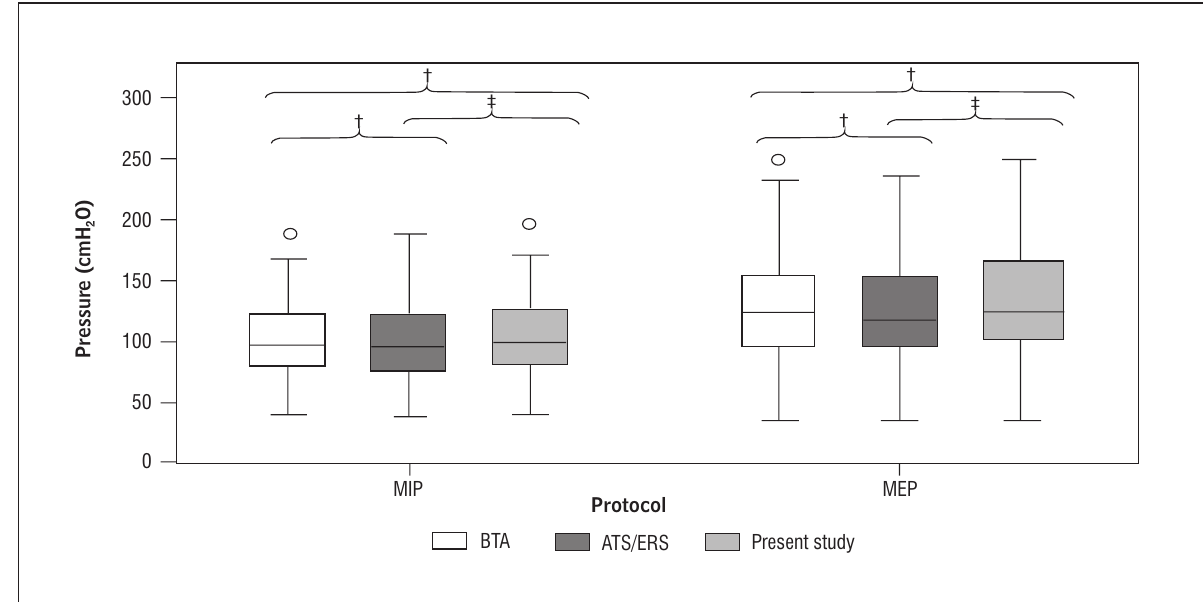
Figure 2 - MIP and MEP values selected using the reproducibility criteria proposed by the Brazilian Thoracic Association (BTA), by the American Thoracic Society / European Respiratory Society (ATS/ERS) and by the present study Note: MIP refers to maximal inspiratory pressure; MEP refers to maximal expiratory pressure and cmH 2 O refers to centimeters of water. ˚ Outlier. MIP data are expressed as absolute values. MIP measurements: repeated measures ANOVA with LSD pos hoc. MEP mea- surements: Friedman test with Wilcoxon post hoc. † Different from SBPT. ‡ Different from